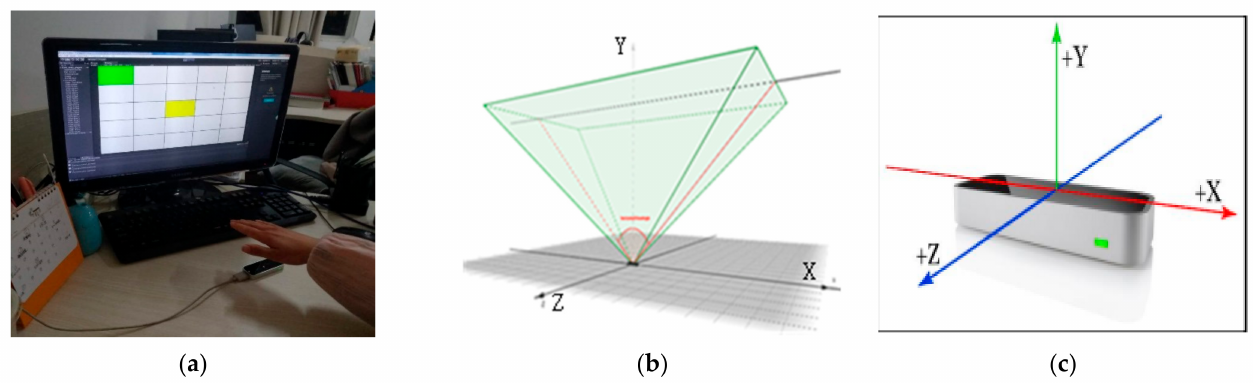
Figure 1. Schematic figure of experimental process and equipment: ( a ) experimental process, including pilot study, experiment 1 and 2; ( b ) the detectable spatial area of Leap Motion; ( c ) coordinate system of Leap